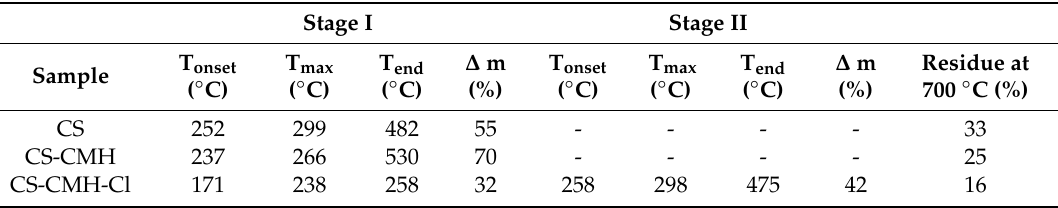
Table 2. Thermal parameters of the tested